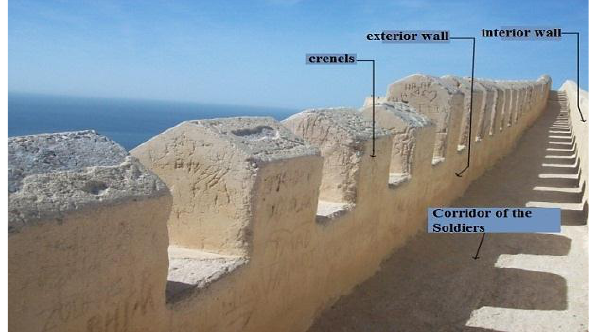
Figure 2. The inner wall above the crenels.